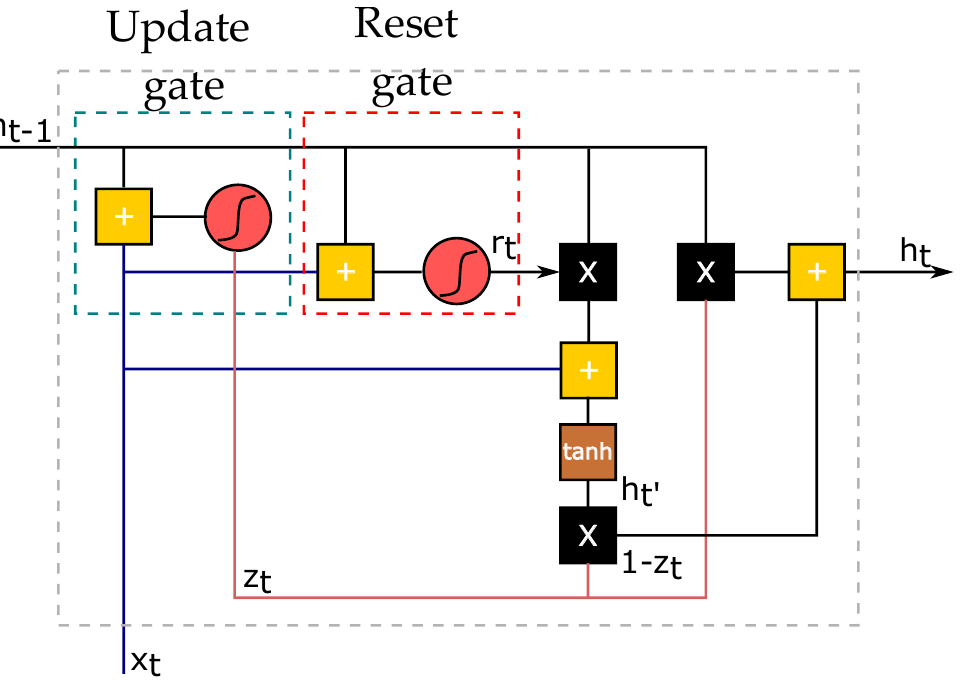
Figure 6. Single GRU